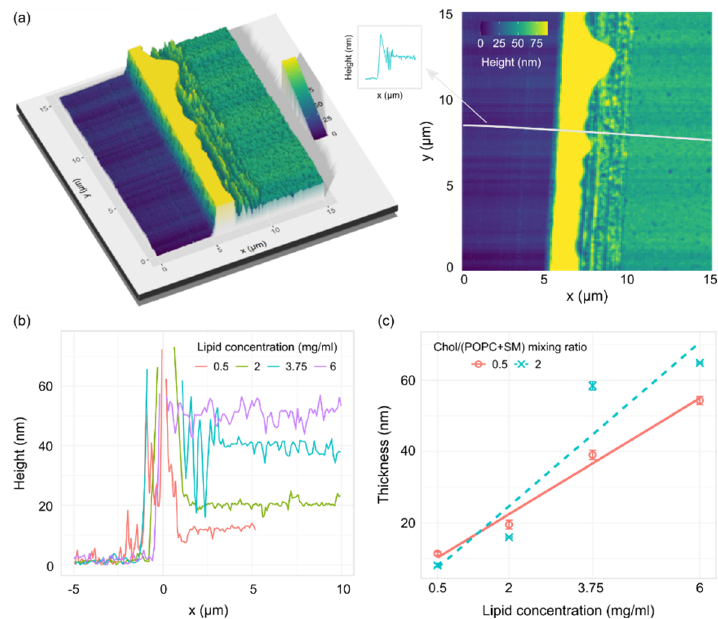
Figure 4. ( a ) 3D (left) and 2D (right) AFM images of a cut on a lipid film made from a 1/1/1 POPC/SM/Chol mixture with a lipid concentration of 3.75 mg/mL. The material buildup on the edge of the trough (yellow hill on the image) is cut off in order to better visualize the rest of the sample. The gray line on the 2D image shows the height profile position. The arrow points to a schematic representation of the height profile used for thickness measurements. ( b ) Representative AFM height profiles for a 1/1/1 POPC/SM/Chol mixture at different lipid concentrations. ( c ) Thickness of the lipid film for two POPC/SM/Chol mixtures depending on the concentration of lipids in the solution used for spin-coating. R 2 = 0.98 and 0.83 for Chol/(POPC + SM) mixing ratios of 0.5 and 2, respectively.